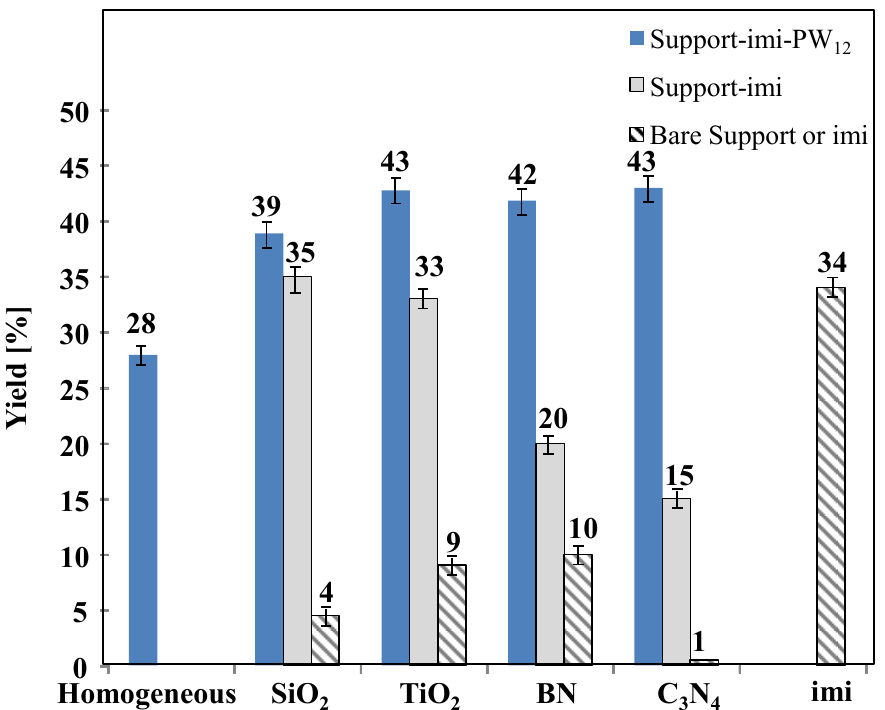
Figure 9. Yield of HMF for catalytic reactions carried out in aqueous medium at 165 °C for 3 h in the presence of the different catalysts showing the different supports. Initial substrate concentration 1 M at natural pH.